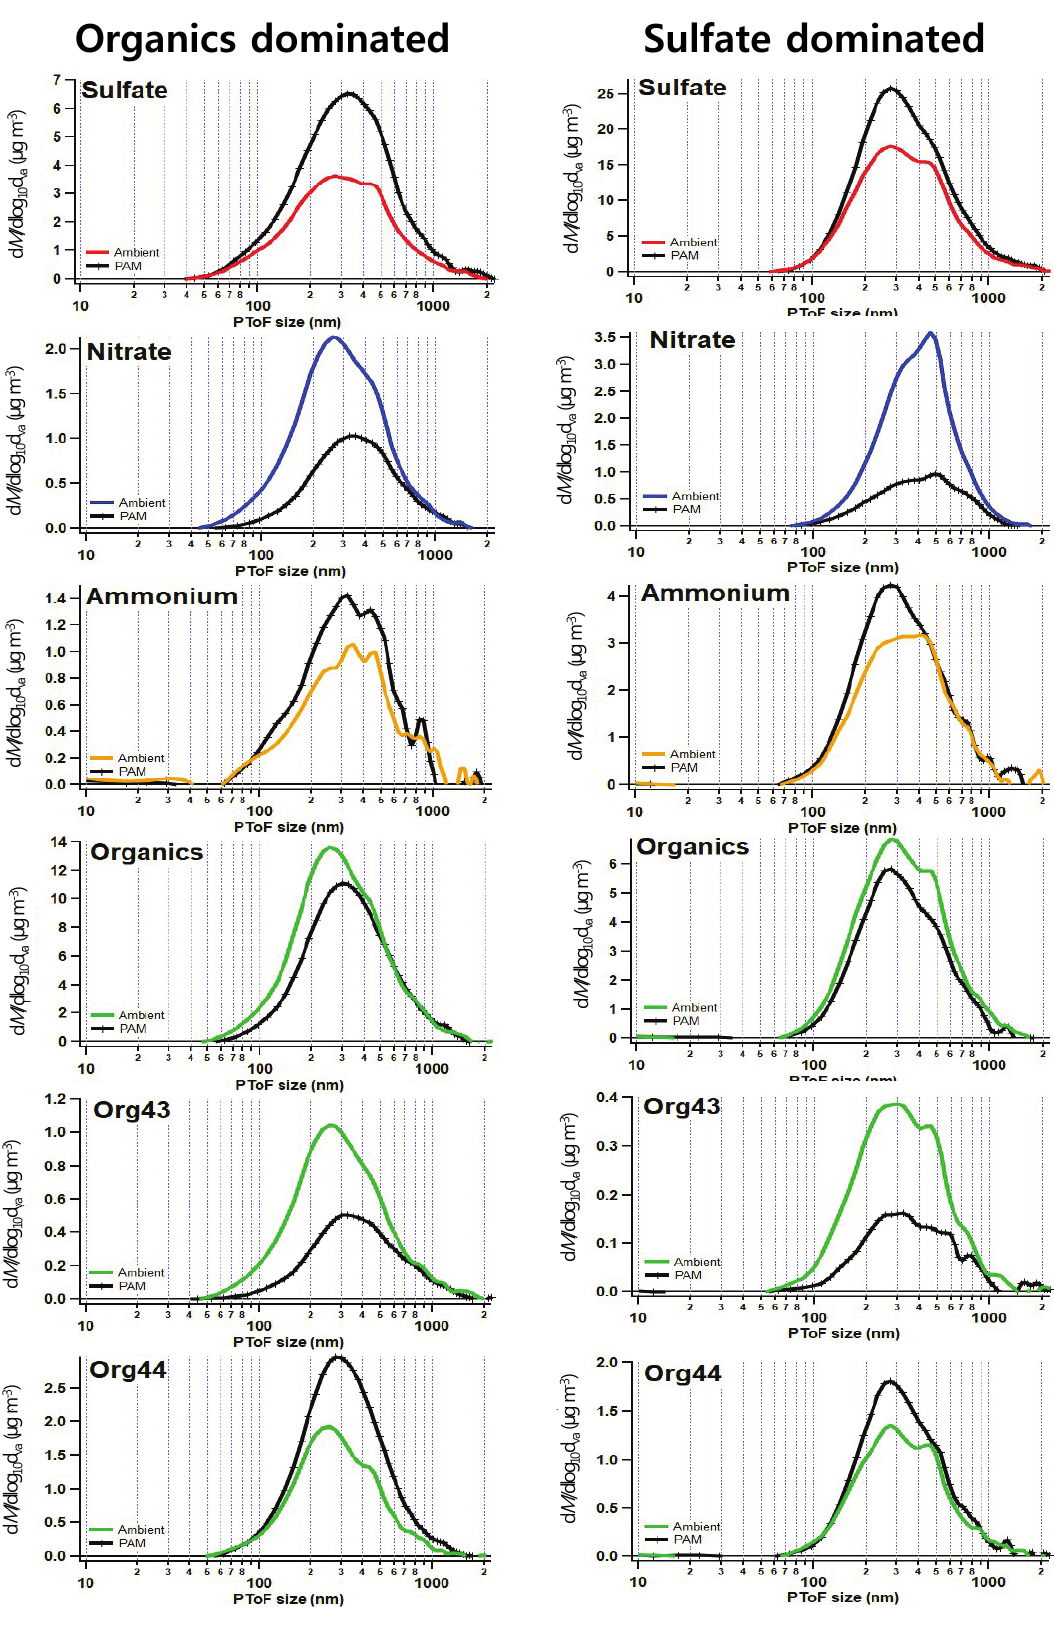
Figure 6. AMS PToF size distributions of PAM and ambient particle components averaged for each